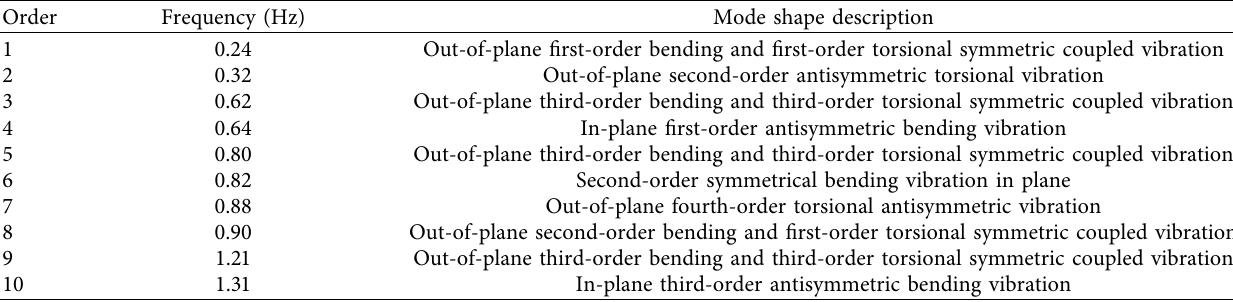
Table 1: Main arch natural vibration characteristics.